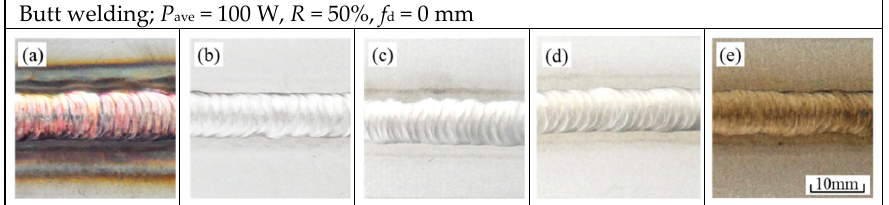
Figure 3. Photos of the laser cleaned surface according to energy density; ( a ) Before laser cleaning, ( b ) 3 J/cm 2 , ( c ) 5 J/cm 2 , ( d ) 7 J/cm 2 , ( e ) 9 J/cm 2 .